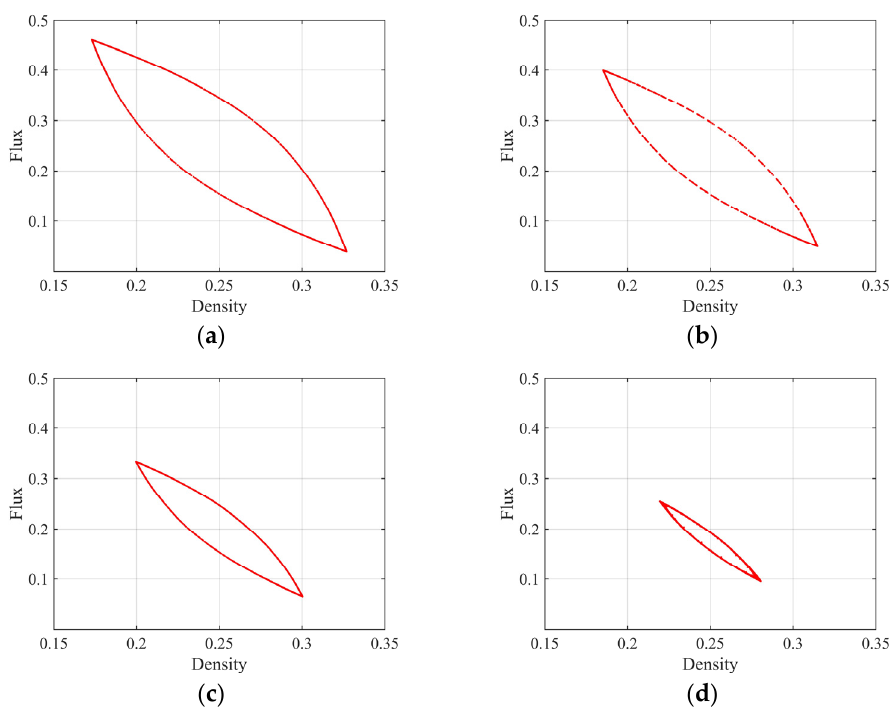
Figure 6. The hysteresis loops of traffic flux and density for different ξ . ( a ) ξ = 0, ( b ) ξ = 0.1, ( c ) ξ = 0.2, ( d ) ξ = 0.3.